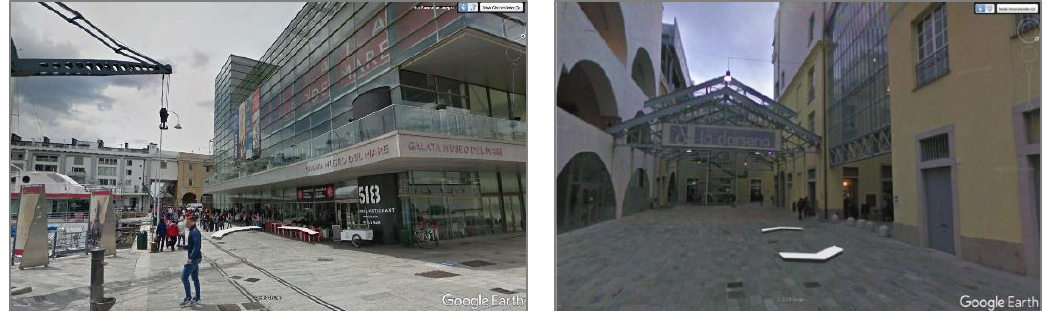
Figure 5 Galata Museo Del Mare Views from the seaside used as the main entrance and from the land used as an emergency exit (URL-3)